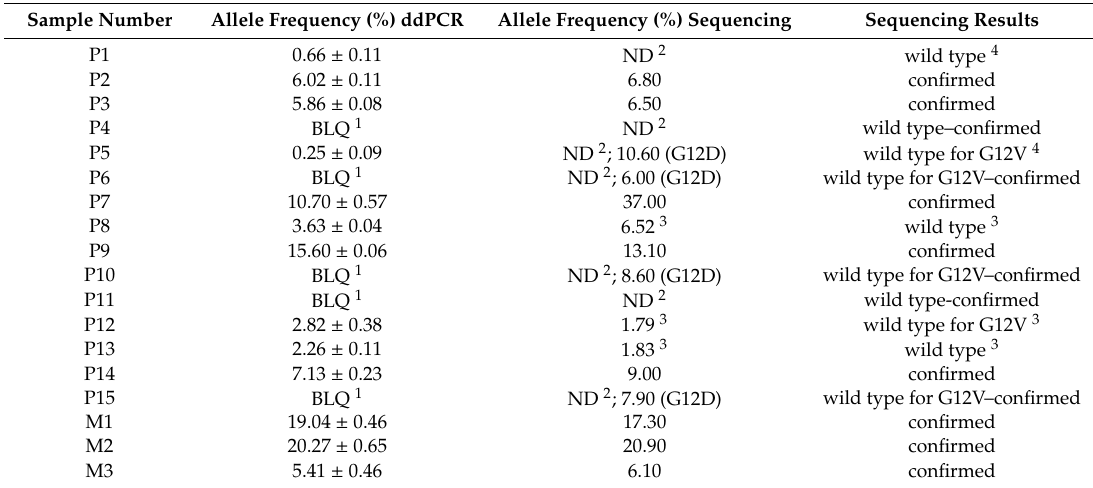
Table 2. KRAS G12V allele frequencies in primary tumors and metastases of PDAC patients. Sample Number